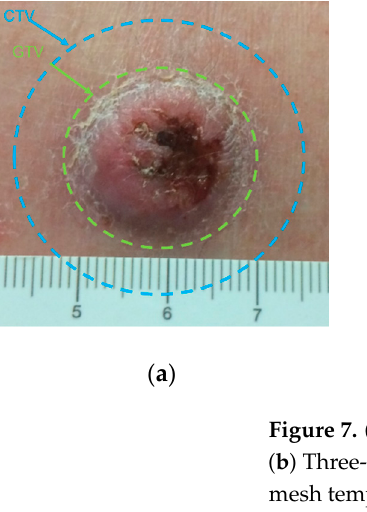
Figure 6. Pre- and post-implant phantom CT fusion, showing the first ( a ) seed insertion plane at 0.26 cm from the surface and the second ( b ) insertion plane at 0.6 cm from the surface.